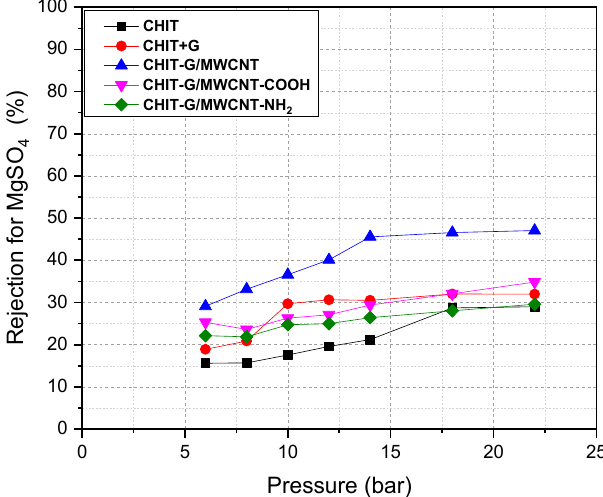
Figure 5. MgSO 4 rejection at pH = 7 with membrane pressure.